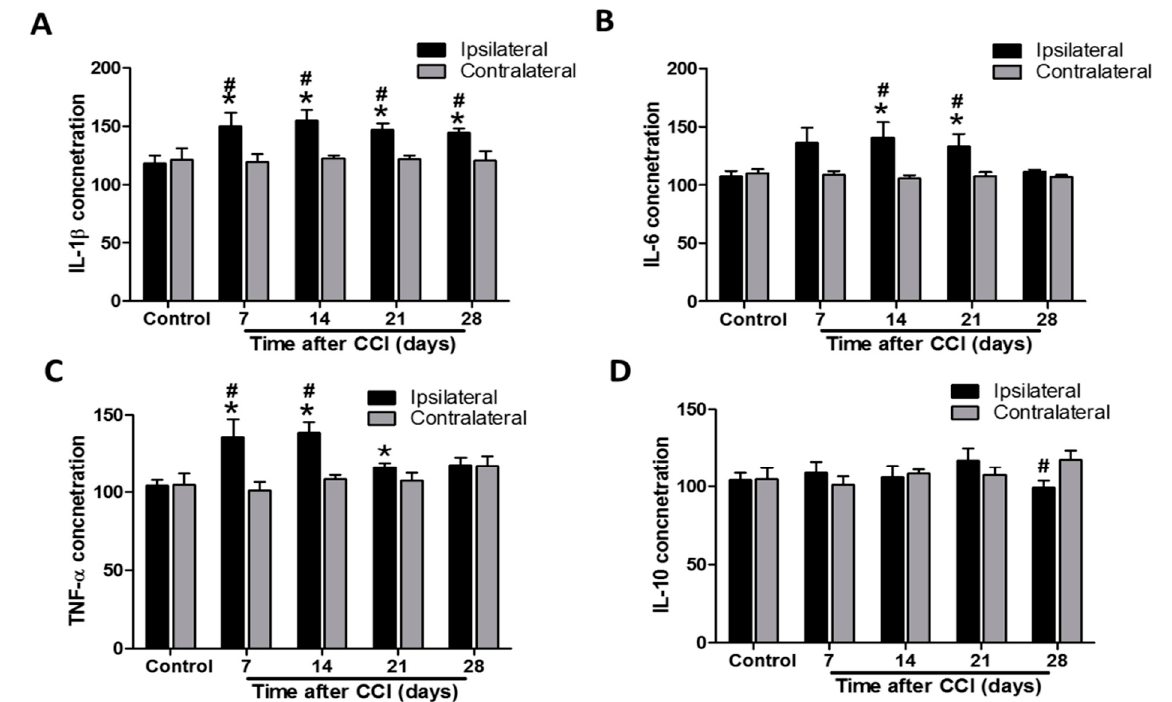
Figure 4. Time course assessment of cytokine levels in the lumbar spinal cord of control rats and chronic constriction injury (CCI) rats at post-operative day (POD) 7, 14, 21, and 28. The levels of interleukin-1 β (IL-1 β ) ( A ), tumor necrosis factor- α (TNF- α ) ( B ), IL-6 ( C ), and IL-10 ( D ) proteins were measured by immunoassay in the dorsal ipsilateral and contralateral parts of the lumbar enlargement. All values were expressed as pg/100 µg total proteins, and means ± standard error of means (SEMs) ( n = 9 per group and each time point) are represented. * p < 0.05 when the protein levels in the same side of the dorsal part of the spinal cord at individual time points were compared to that in control rats. # p < 0.05 when the protein levels in the ipsilateral dorsal part of the spinal cord were compared to those in the contralateral side at the same timepoint, one-way analysis of variance (ANOVA) with post hoc Tukey test.